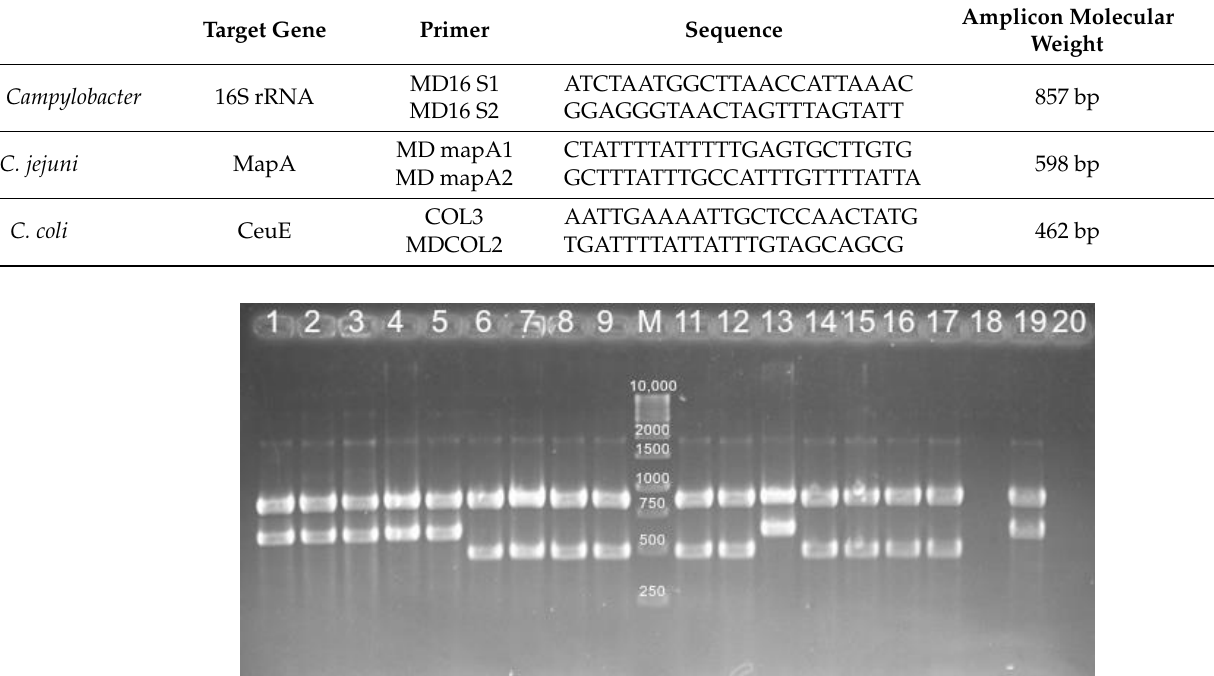
Table 2. Primers used for the identification of C. jejuni and C. coli.